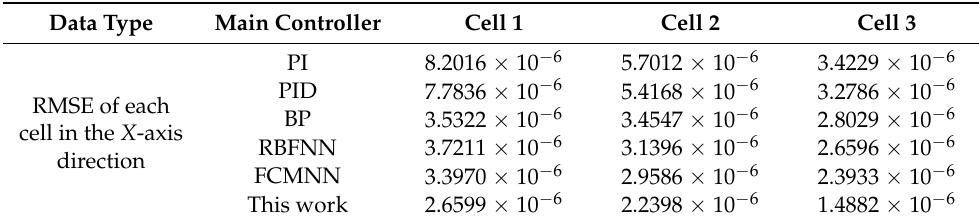
Figure 13. The trajectory error on the Y -axis (multicellular manipulation): ( a ) Use PI as a controller. ( b ) Use PID as a controller. ( c ) Use BP as a controller. ( d ) Use RBFNN as a controller. ( e ) Use FCMNN as a controller. ( f ) Use FBELNN as a controller. Table 4. RMSE of multicellular